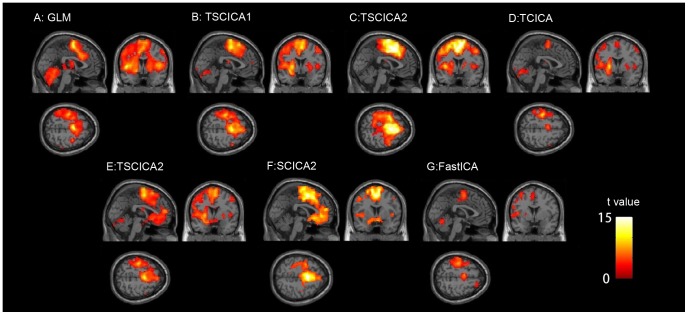
The spatial activation that was estimated by all of the methods.(A) The activated regions that were detected by GLM. (B) The activated regions of the target component that were estimated by TSCICA using the first spatial reference. (C) The activated regions of the target component that were estimated by SCICA using the first spatial reference. (D) The activated regions of the target component that were estimated by TCICA. (E) The activated regions of the target component that were estimated by TSCICA using the second spatial reference. (F) The activated regions of the target component that were estimated by SCICA using the second spatial reference. (G) The activated regions of the target component that were estimated by FastICA.